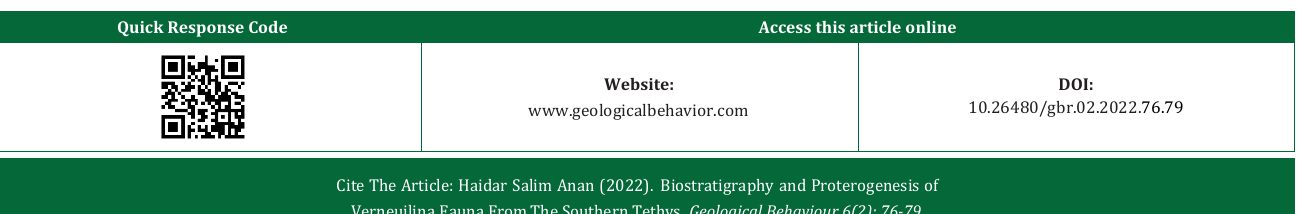
Figure 1: Paleocene paleogeographic map of the Tethys: Spain, Tunisia, Egypt, Jordan, Iraq, Qatar, UAE, Iran and Pakistan (Morsi et al., 2008).